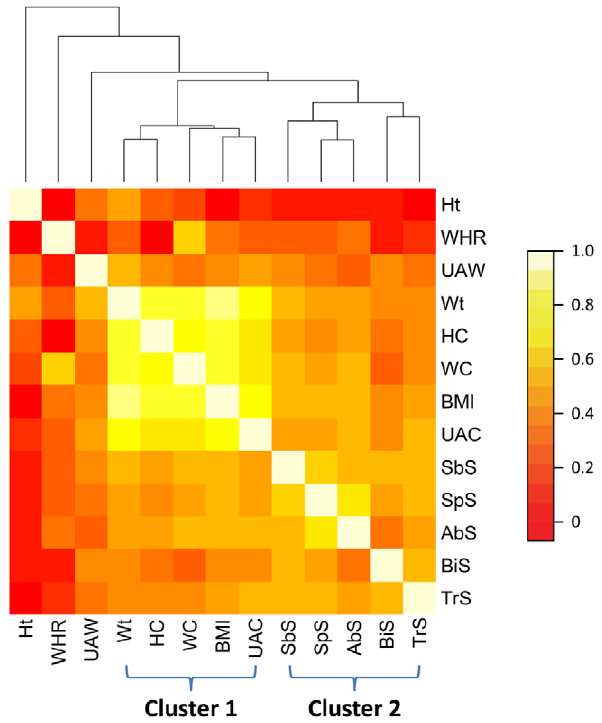
Figure 2. Hierarchical clustering of the 13 anthropometric